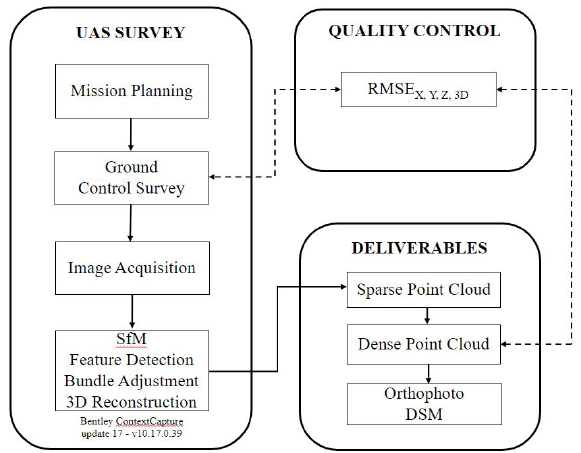
Figure 1 . Flowchart of the methodology.